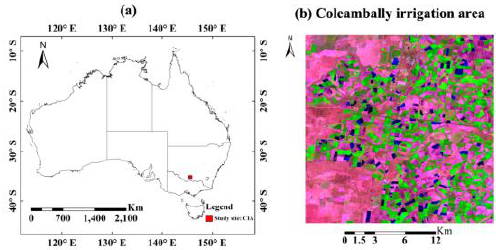
Figure 1: a ) A map of Australia with the Coleambally irrigation area labeled in a red square; ( b ) The false color composite image of Landsat-7 spectral bands SWIR1, NIR, and Red acquired on 8 October 2001. After (Chen et al.,